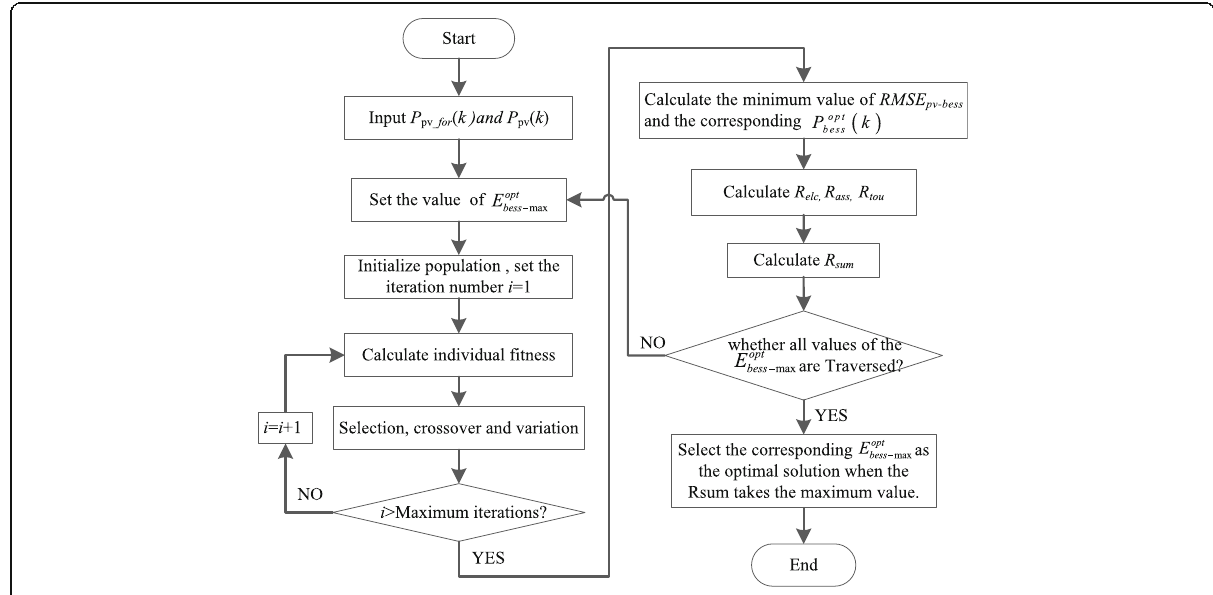
Fig. 3 The joint benefit model solving process of typical scenario for PV-BESS